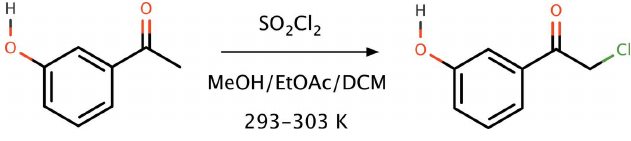
Figure 4 The overall reaction scheme for the synthesis of I